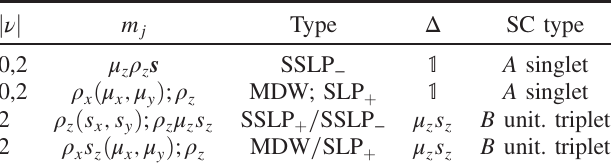
TABLE IV. Possible particle-hole m and superconducting j order parameters Δ that can exhibit mutual WZW terms at the indicated filling fractions ν ¼ 0 and j ν j ¼ 2 . Here we use the Dirac notation of Eqs. (7.4) and (7.5). As in Ref. [25], moiré density wave (MDW) indicates that the state breaks moiré translational symmetry; A and B refer to the irreducible repre- sentations of the point group C 6 of the superconductor (SC). The MDW with singlet pairing row below corresponds to the first row of Table IV in Ref. [25], while the MDW with triplet SC corresponds to the first row of Table VII (or more explicitly, in lines 5 and 9 of Table